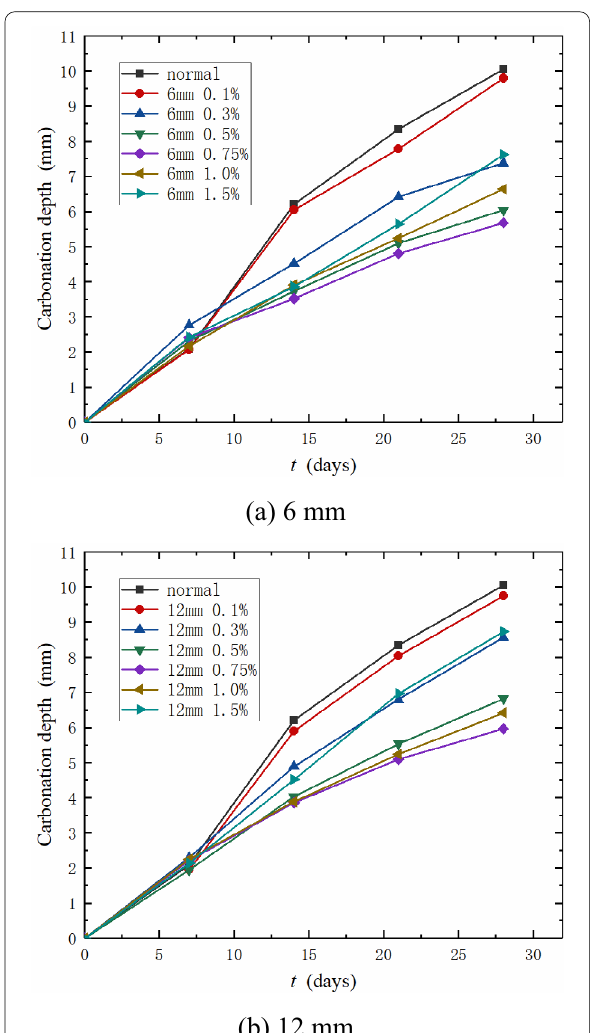
Fig. 3 Time evolution of carbonation depth in the PVA fiber concrete with fiber lengths of 6 mm and 12